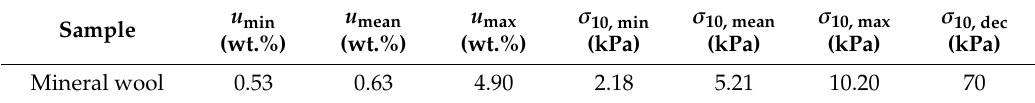
Table 1. Water content ( u ) and compressive strength ( σ ) of degraded mineral wool from basalt fibers.